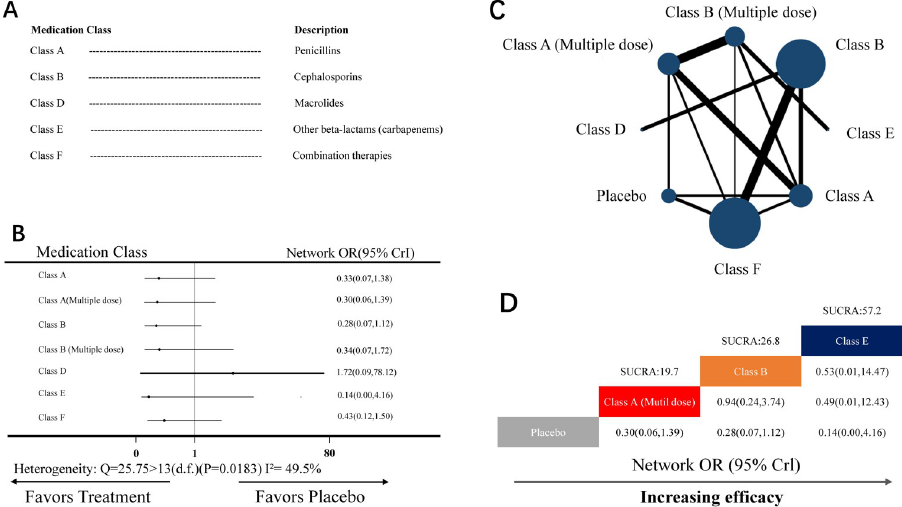
Fig 4. NMA for febrile morbidity. (A) List of the included medication classes. (B) Forest plot of the NMA comparing each intervention against placebo. (C) Each node (blue circles) represents a unique medication class and dosage, and the size of each node represents the number of included women for the intervention. The connecting line indicates the number of direct comparisons between both nodes. The width of each line represents the number of direct comparisons between interventions. (D) Schematic detailing the most efficacious antibiotic class and dosage in NMA for febrile morbidity compared with placebo for surface under the cumulative ranking curve analysis (SUCRA). NMA, network meta-analysis; OR, odds ratio; CrI, credibility